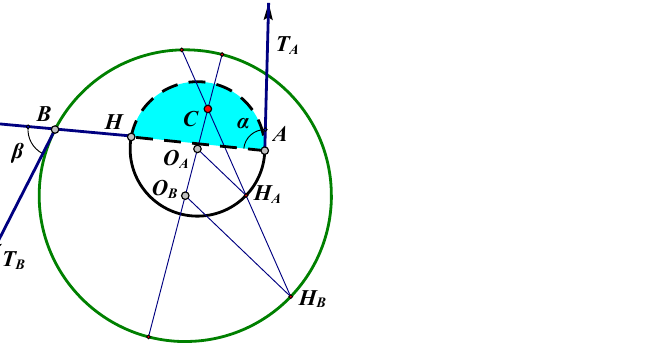
Figure 3. G 2 Hermite data that can be interpolated by a spiral and the external homothetic center C . (cid:107)−−−→ O A O B (cid:107) < r B − r A means k A > k B , and curvature circle (cid:12) O A is contained in (cid:12) O B